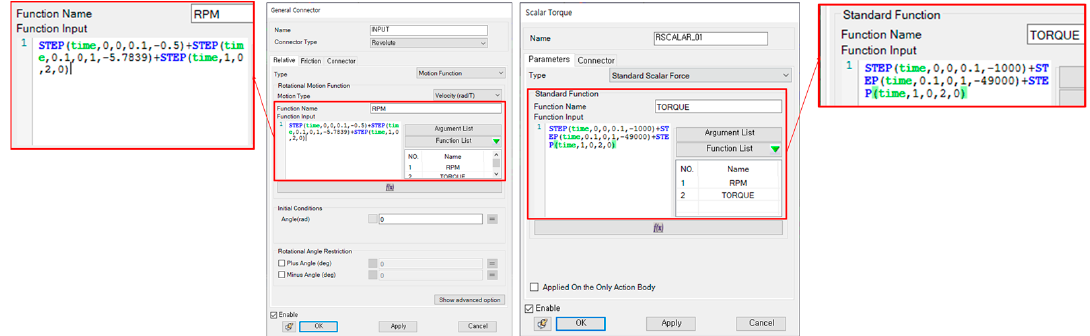
Figure 15. Setting the rotational velocity of the driving gear and the rotational load of the driven gear.